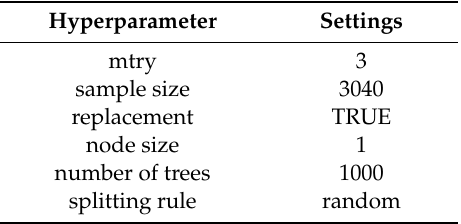
Table 5. Random forest approach—hyperparameter settings.